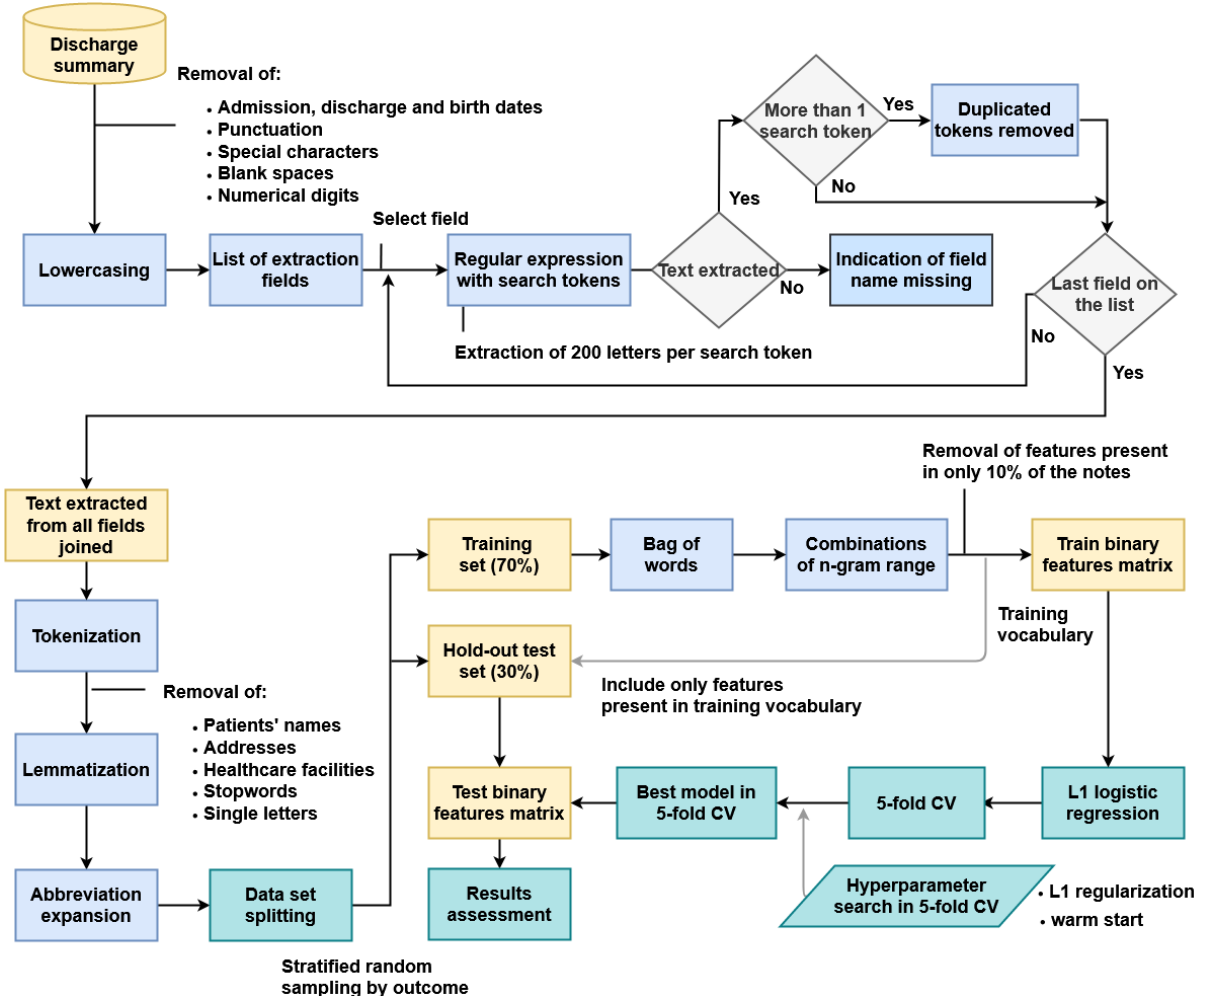
Figure 1. Methodology steps for discharge summary notes preprocessing and modeling. The list of extraction field is depicted in Table